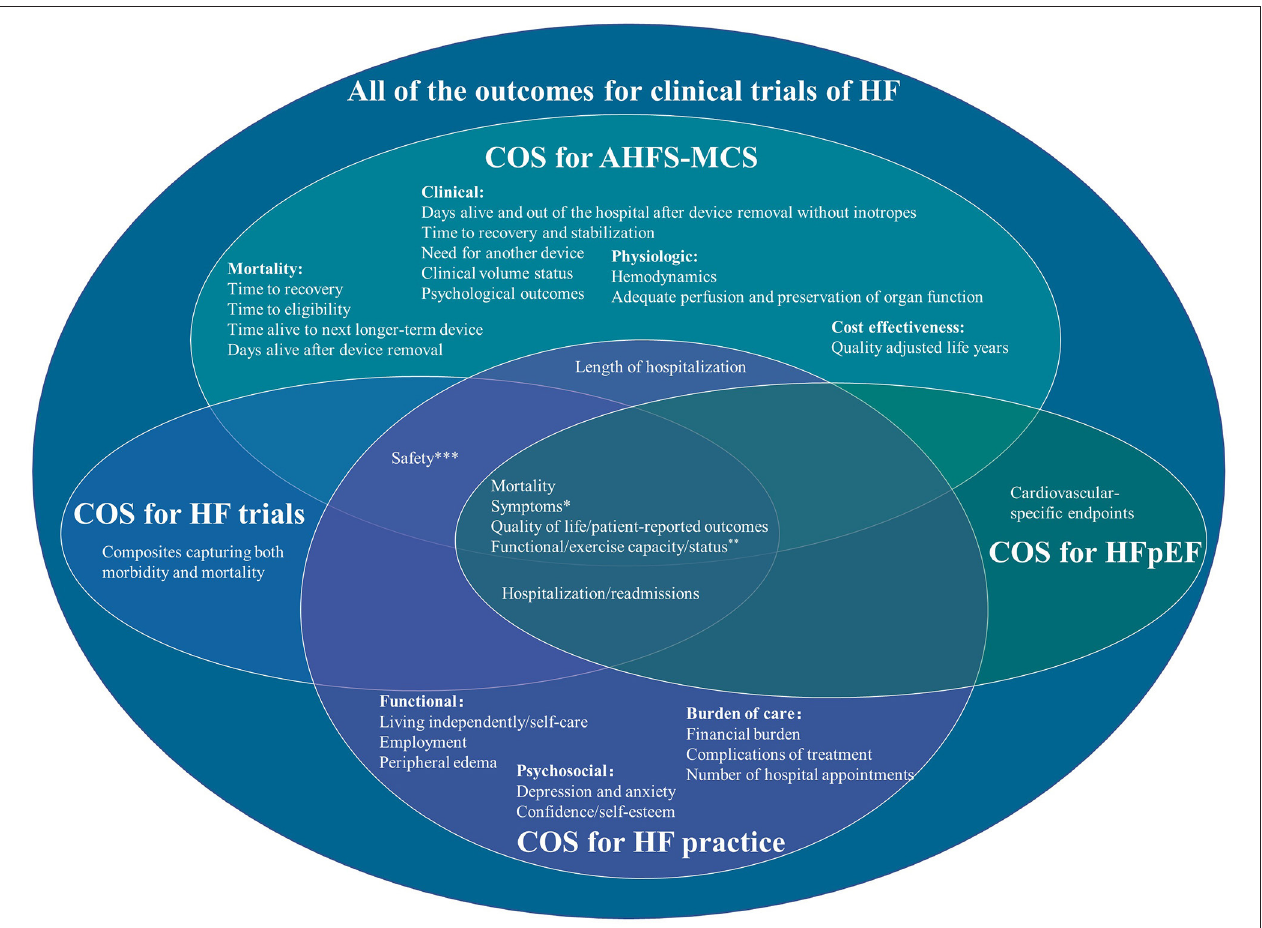
FIGURE 1 | Outcomes in different core outcome sets of heart failure. *COS for AHFS-MCS: dyspnea and fatigue, COS for HF practice: shortness of breath, fatigue and tiredness, and disturbed sleep. **COS for AHFS-MCS: VO2, 6-min walk, and NYHA Class, COS for HF practice: maximum level of physical exertion. ***COS for AHFS-MCS: infection, stroke, bleeding, device failure or malfunction, procedural complications, need for device repair/removal/re-implantation. COS for HF practice: medication